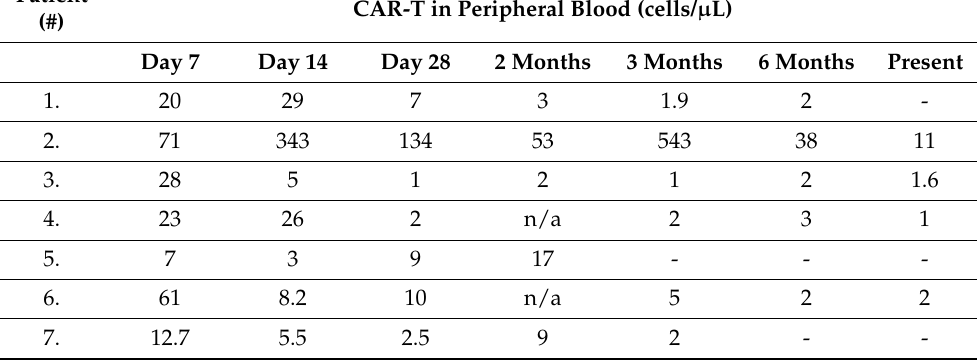
Table 3. CAR-T expansion in the patients’ blood; abbreviations: n/a—not assessed.